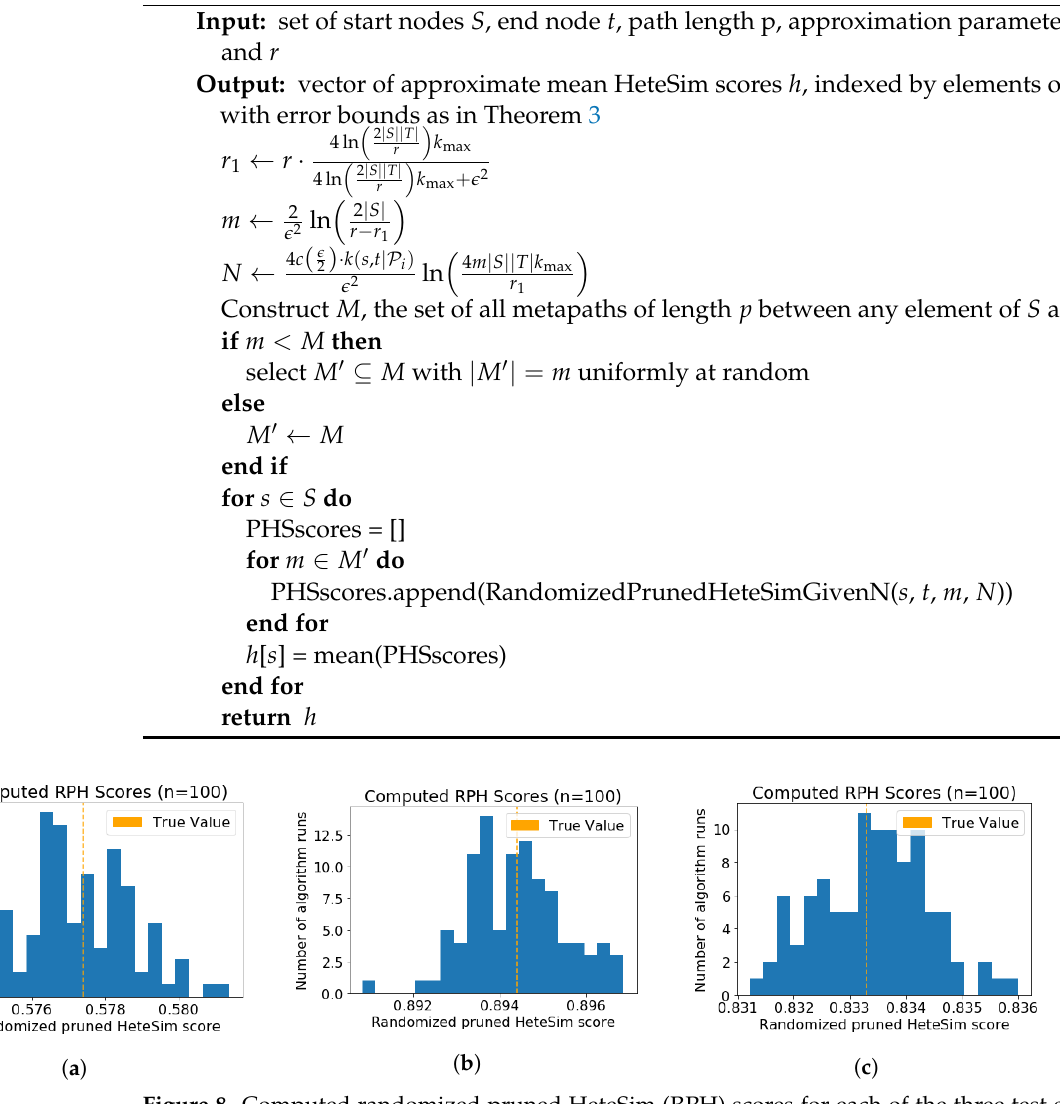
Figure 8. Computed randomized pruned HeteSim (RPH) scores for each of the three test graphs. ( a ) Test graph 1; ( b ) Test graph 2; ( c ) Test graph